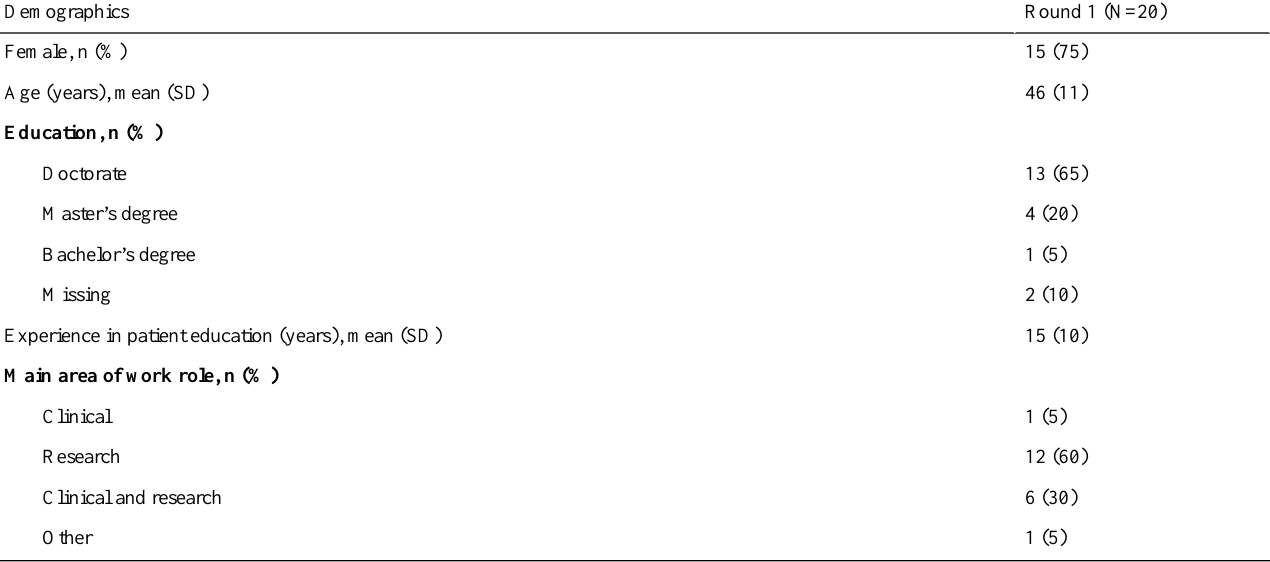
Table 1. Electronic Delphi (eDelphi) panel